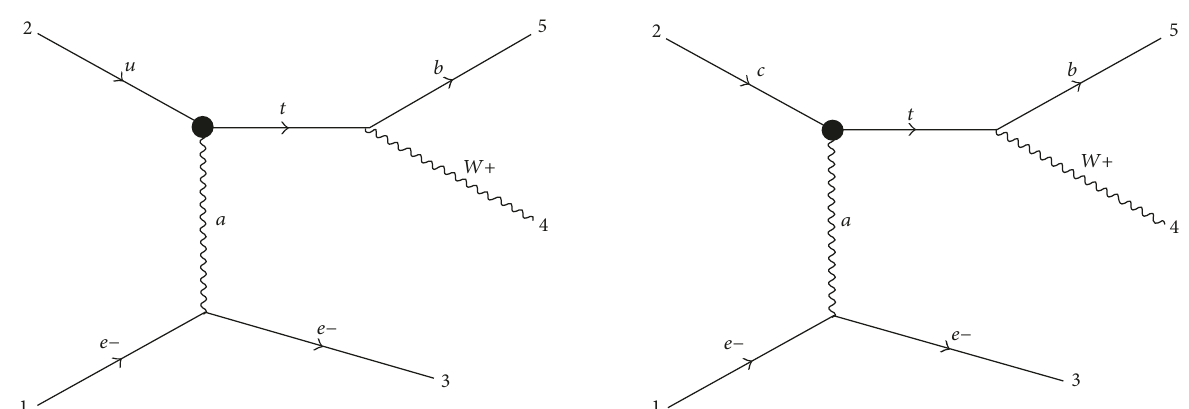
Figure 1: Leading order diagrams for single top quark production via flavour changing neutral currents and its subsequent decay. The similar diagrams for single anti-top production can be obtained by exchanging 𝑢 ↔ 𝑢 and 𝑐 ↔ 𝑐 and its corresponding subsequent decay.